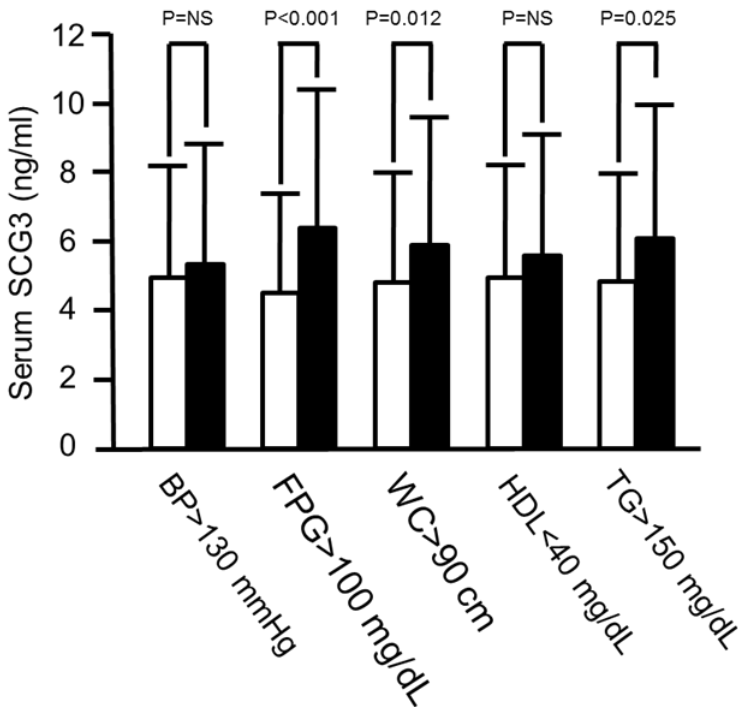
Figure 2. Comparisons of serum secretogranin III levels between subjects with/without each component of metabolic syndrome.